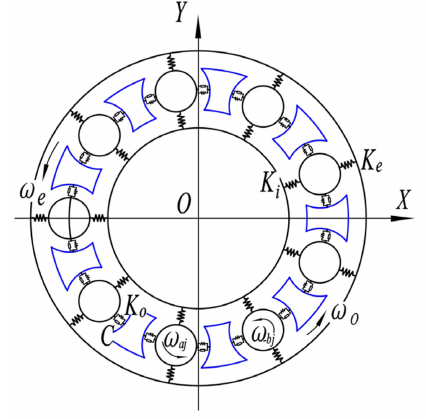
Figure 7. The dynamic model of needle roller